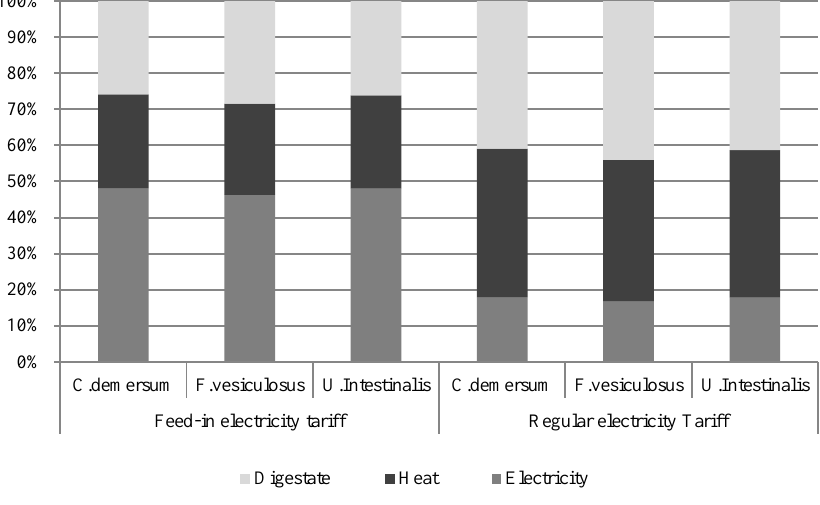
Fig. 4. Revenue structure of